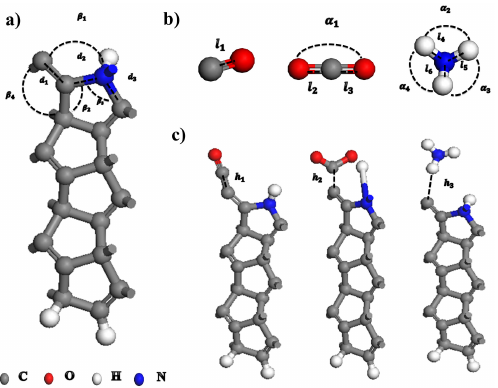
Figure 2: Adsorption configurations of C-H- N:SSPGNR consist of: a) C-H-N:SSPGNR, b) isolated gas molecules and c) configurations of C-H-N:SSPGNR after adsorption gas